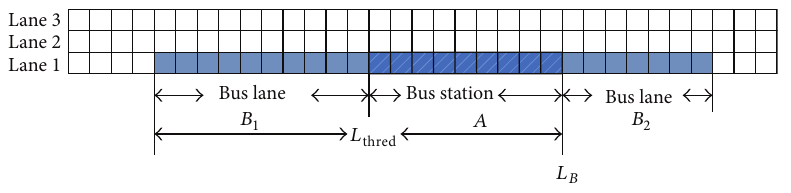
Figure 1: Schematic illustration of bus station.